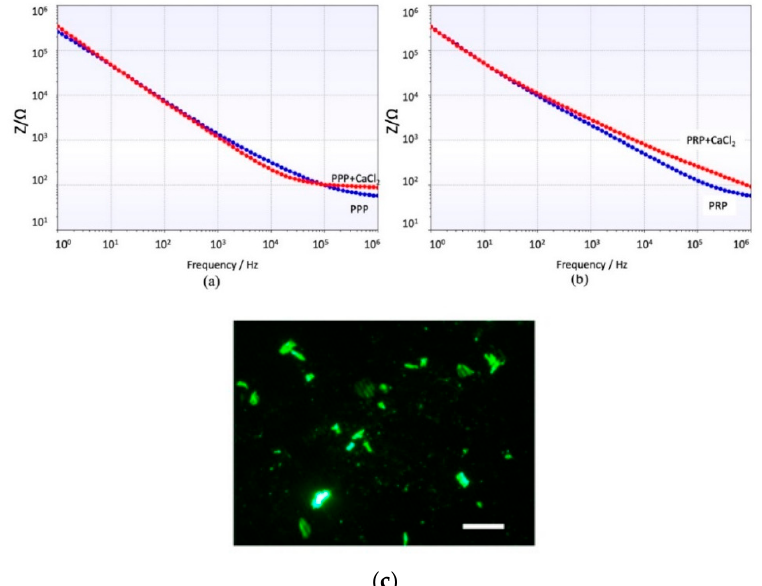
Figure 5. Impedance module at different frequencies after 90 s interaction of the electrode with ( a ) PPP and PPP + CaCl 2 . ( b ) PRP and PRP + CaCl 2 . ( c ) Image of the platelets attached on the electrodes. Scale bar = 10 µm.